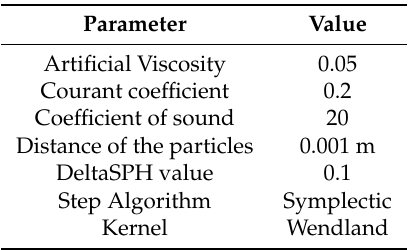
Table 2. Parameters of the numeric